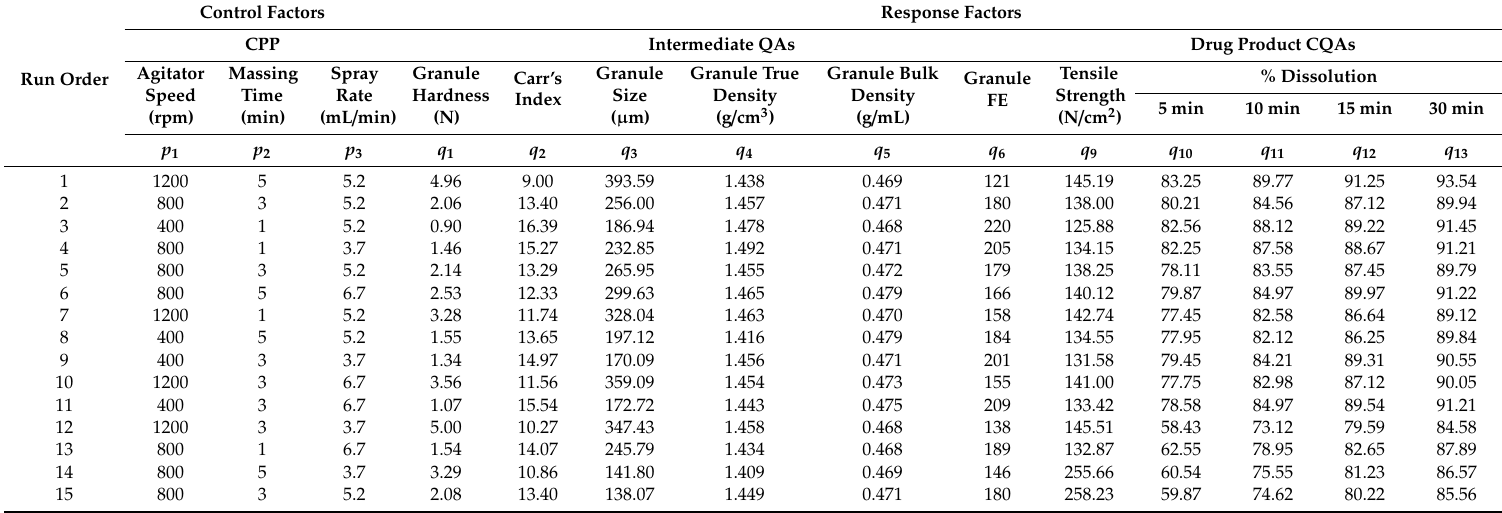
Table 3. Experimental design of high-shear wet granulation process parameters with three input control factors and values of the response factors for di ff erent process